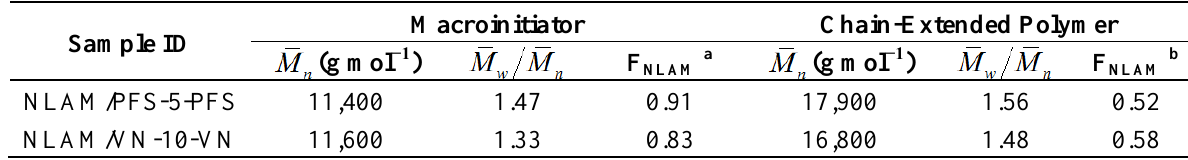
Table 4. Molecular characterizations for NLAM/PFS-5 and NLAM/VN-10 chain extensions with PFS and VN, respectively. Sample ID